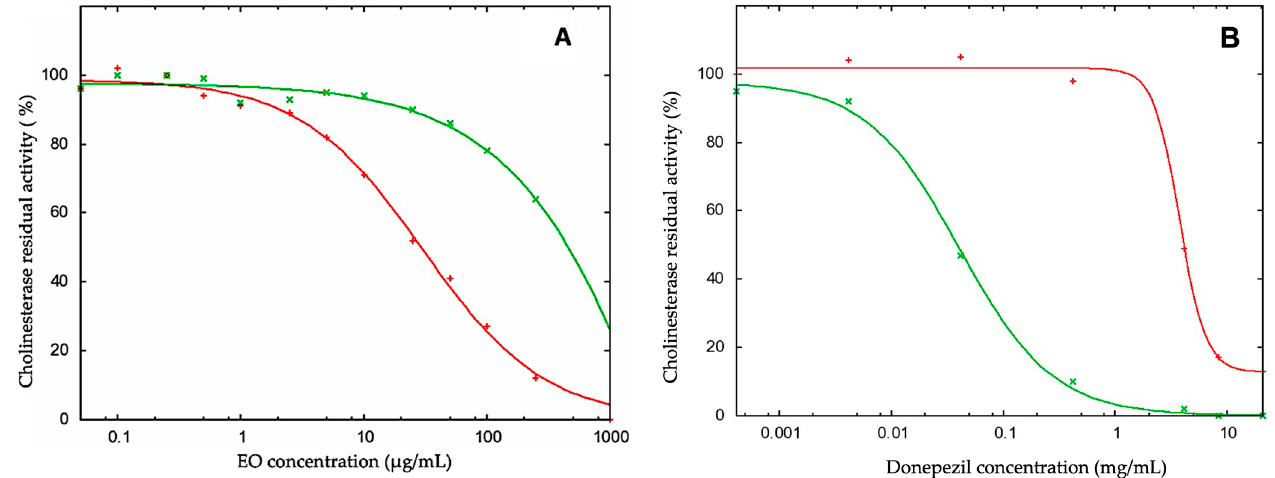
Figure 2. Half maximal inhibition concentration (IC 50 ) of C. taxifolium essential oil ( A ) and donepezil ( B ) against AChE (green curve) and BChE (red curve).